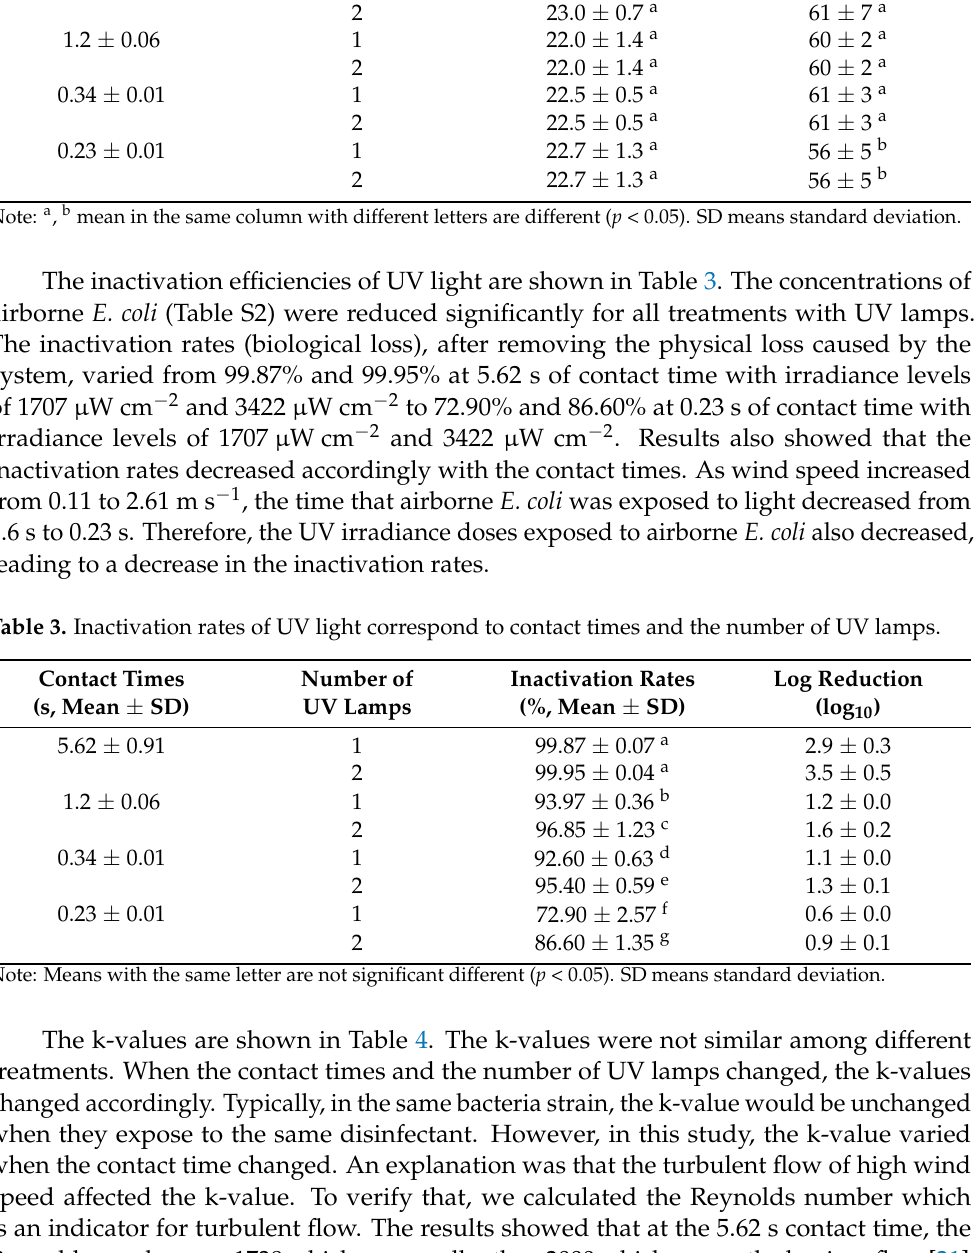
Table 2. Temperature and relative humidity correspond to contact times and the number of UV lamps. Contact Times Number of (s, Mean ± SD) UV Lamps